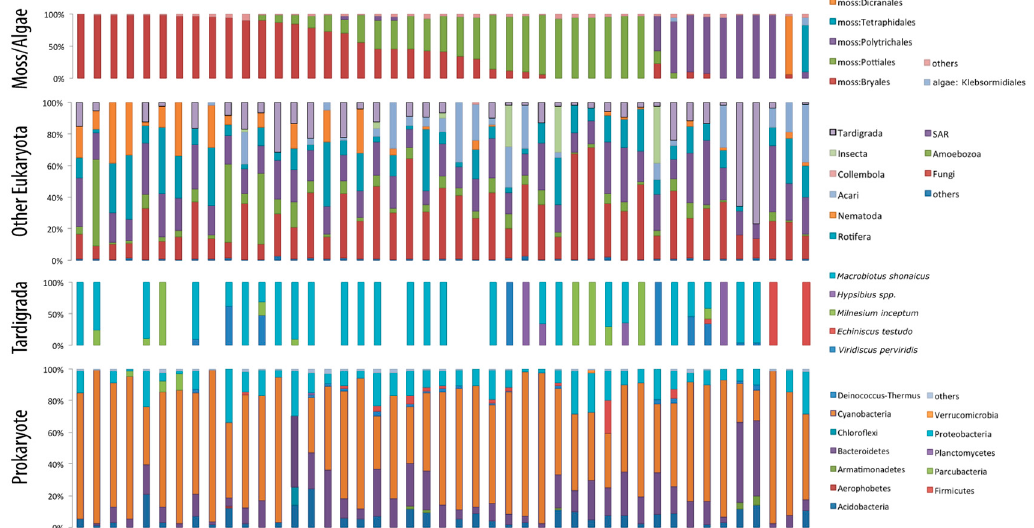
Figure 2. Amplicon abundance ratios in xeric mosses. Relative abundances of amplicon reads within OTUs assigned to moss / lichen, other Eukaryota, tardigrades, and bacteria are shown separately. The moss samples were mostly from Bryum argenteum (Bryales), and as the sampled location was the type locality of Macrobiotus shonaicus , we see several moss contained 18S amplicons from this species. The majority of bacteria consisted of Cyanobacteria, Proteobacteria, and Bacteroidetes.